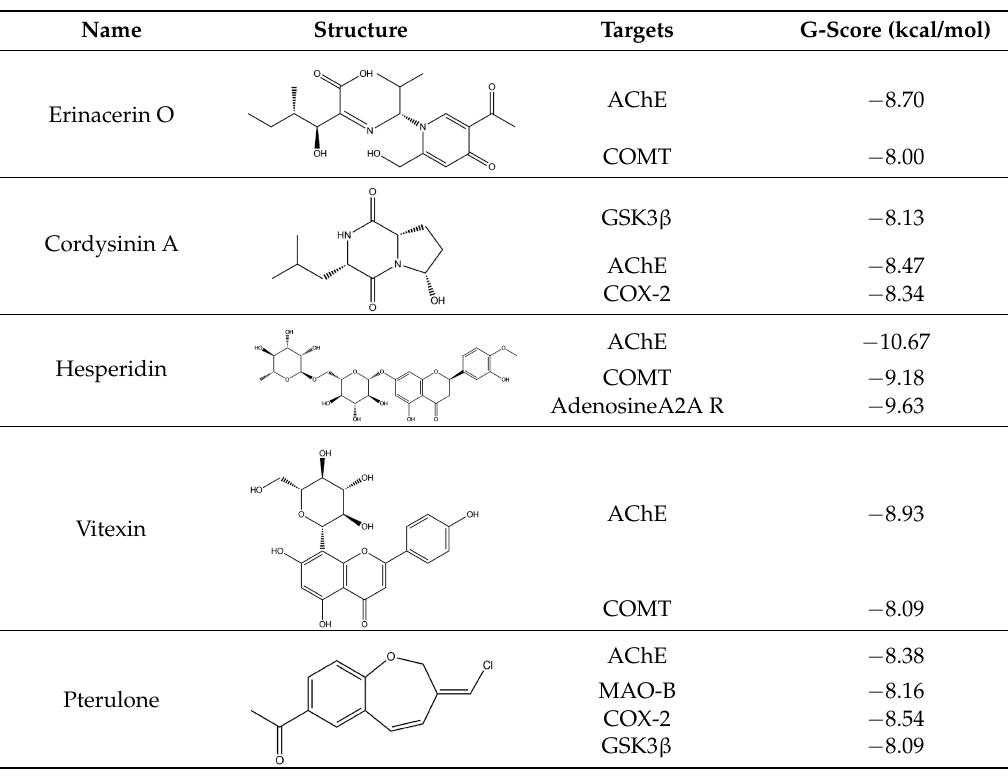
Table 3. Fungal components with best theoretical affinities (G-score) against multiple targets involved in the neurodegenerative diseases.